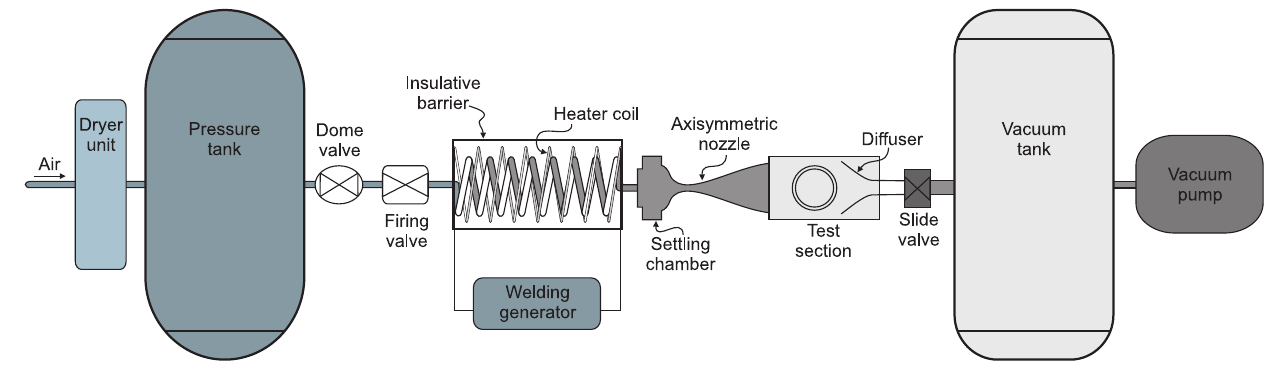
Figure 2. High supersonic tunnel (HSST)